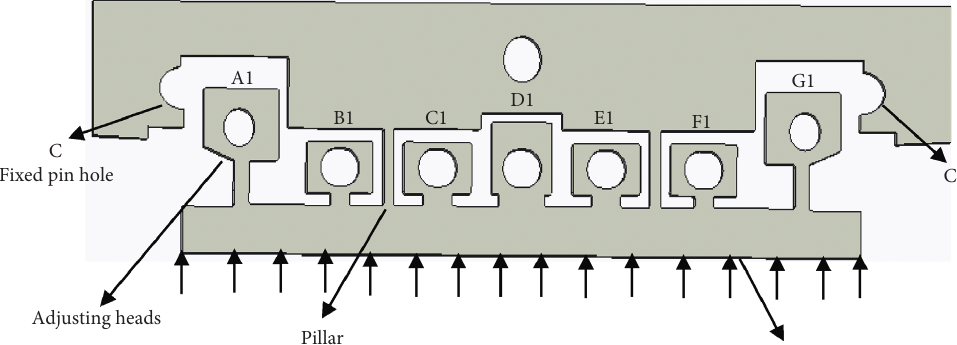
Figure 10: The model of grinding fixture.